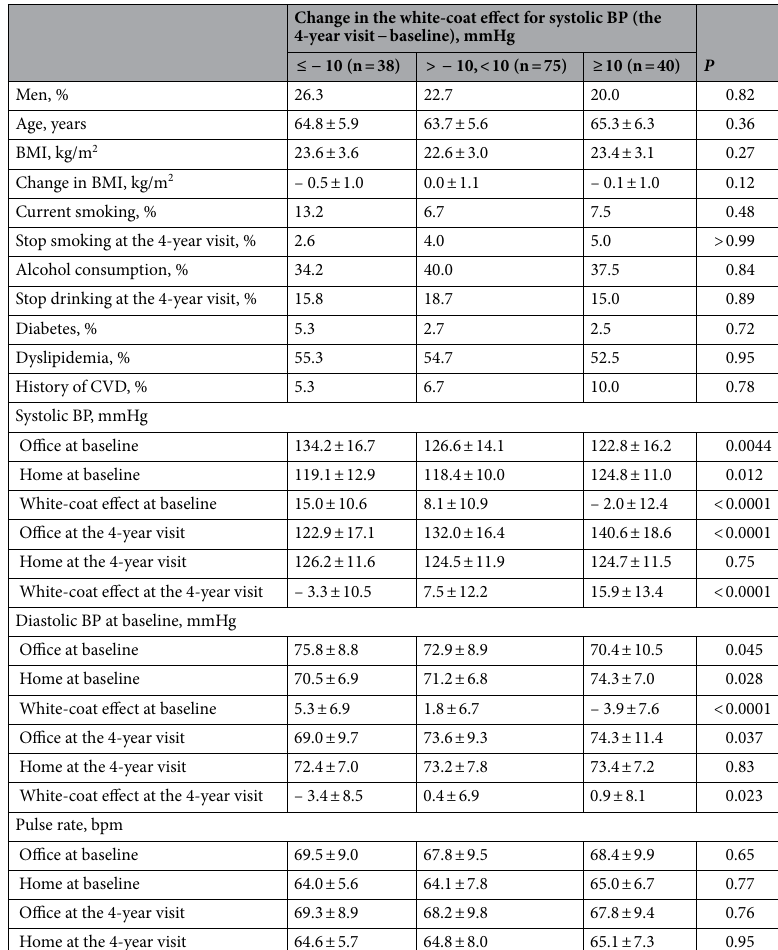
Table 4. Characteristics according to the white-coat effect. BMI body mass index, CVD cardiovascular disease, BP blood pressure.